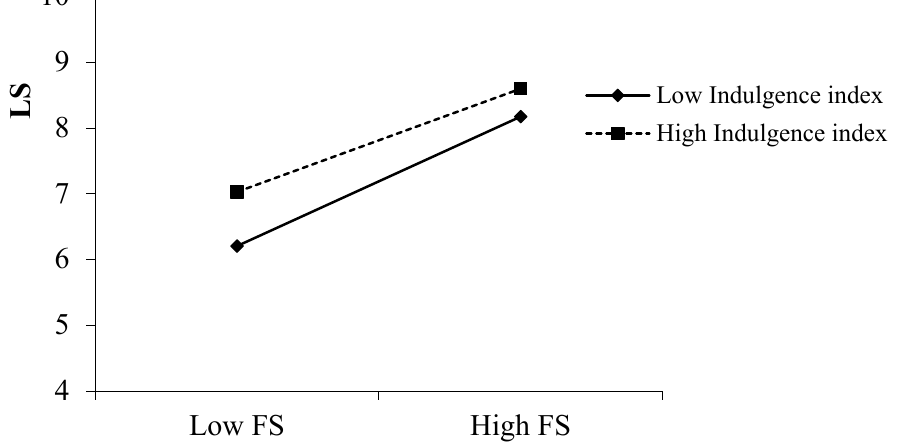
Figure 2. Interaction between Financial Satisfaction (FS) and Indulgence versus Restraint (IVR) in predicting Life Satisfaction (LS) in study 1.